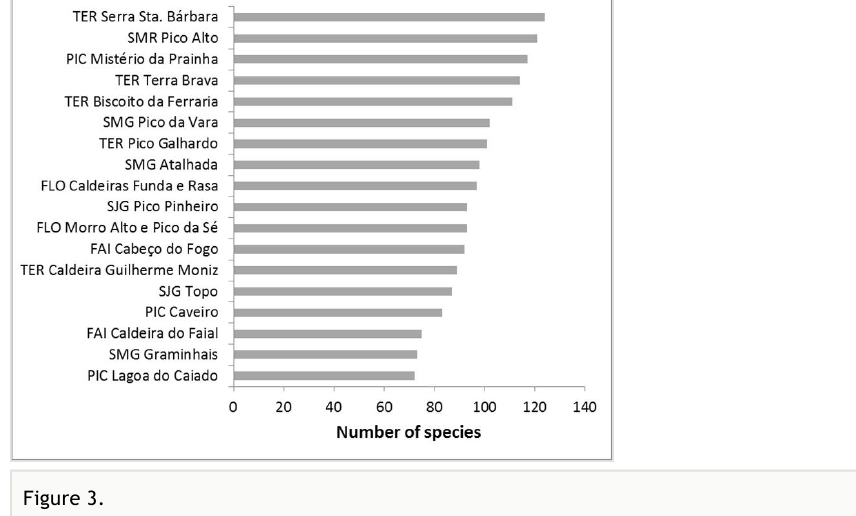
The number of species identi fi ed for each of the 18 native forest fragments surveyed is shown in Fig. 3. The fragment with the highest species diversity is Serra de Santa Bárbara in Terceira island (S = 124), which is also the larger native forest area in the Azores. Remarkably, one of the smallest fragments, Pico Alto in Santa Maria island, is the second most diverse (S = 121).